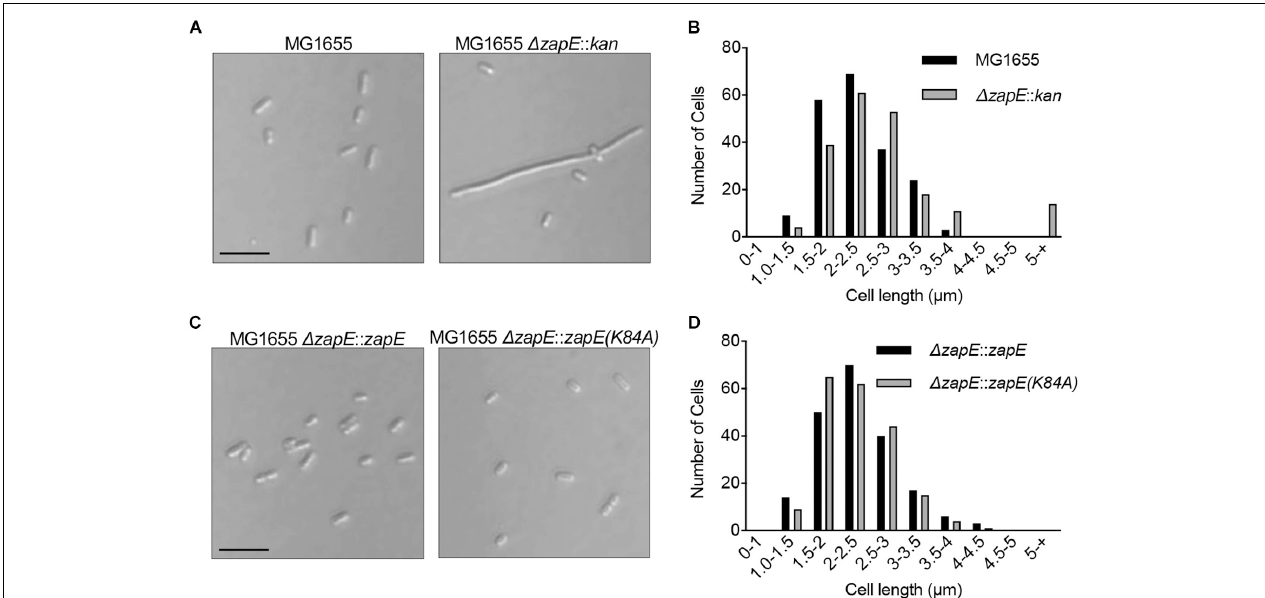
FIGURE 4 | Cell morphology of E. coli strains deleted for zapE. (A) Log phase cultures of MG1655, MG1655 (cid:49) zapE grown at 35 ◦ C in LB. Cells were collected and added to poly- L -lysine-coated coverslips and observed by DIC microscopy. Size bar is 5 µ m. (B) Cell length distribution of MG1655 and MG1655 (cid:49) zapE from morphology experiment in (A) ( n = 200 cells). (C) Expression of ZapE wild type or mutant protein was restored in MG1655 (cid:49) zapE with wild type zapE or zapE(K84A) at the native locus in the chromosome by recombination. Log phase cultures of MG1655 (cid:49) zapE : zapE and MG1655 (cid:49) zapE : zapE(K84A) were grown at 35 ◦ C in LB. Cells were collected and added to poly- L -lysine-coated coverslips and visualized by DIC microscopy. Size bar is 5 µ m. (D) Cell length distribution of MG1655 (cid:49) zapE : zapE and MG1655 (cid:49) zapE : zapE(K84A) from morphology experiment in (C) ( n = 200